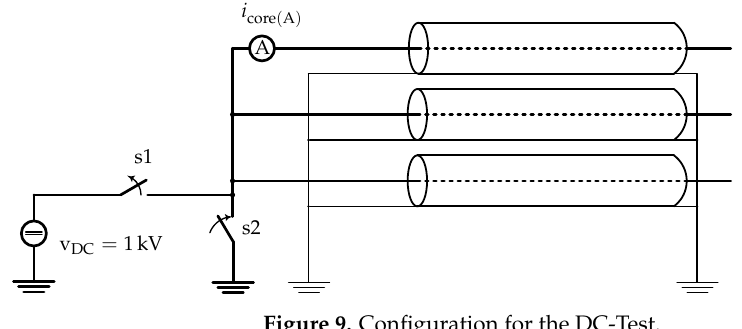
Figure 9. Configuration for the